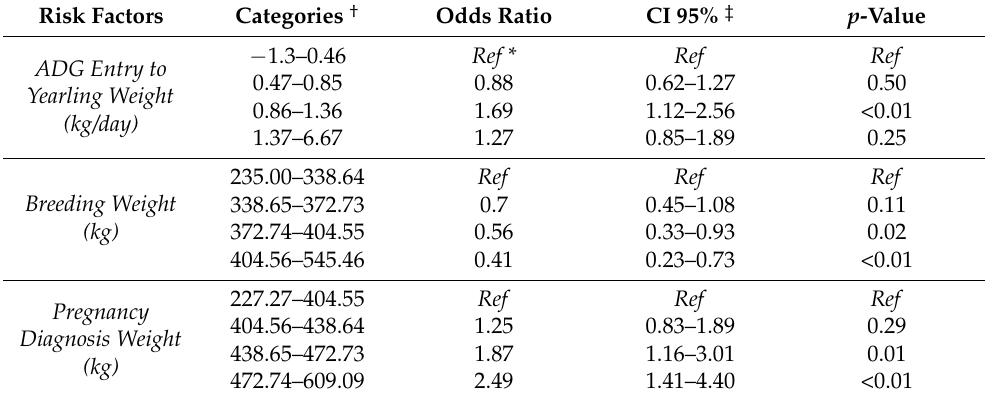
Table 3. Results of the final multivariable logistic regression model for